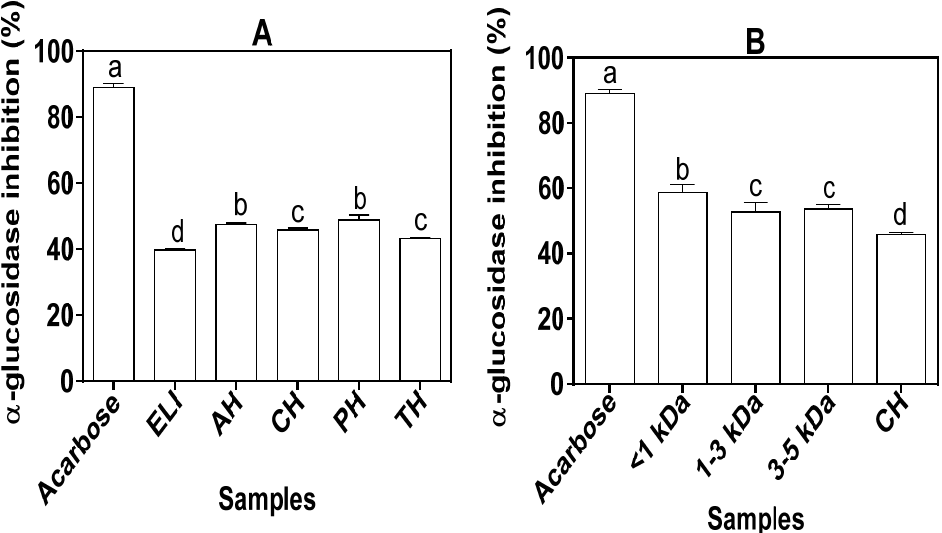
Figure 6. α -glucosidase inhibitory activities of ( A ) acarbose (standard), eggplant leaf protein isolate (ELI) and protein hydrolysates alcalase (AH), chymotrypsin (CH), pepsin (PH) and trypsin (TH), and ( B ) α -amylase inhibitory activities of ultrafiltration peptide fractions of CH and acarbose (standard). Values are mean ± standard deviation of three determinations. Bars with different letters (a-d) on the same layout are significantly different ( p ≤ 0.05)